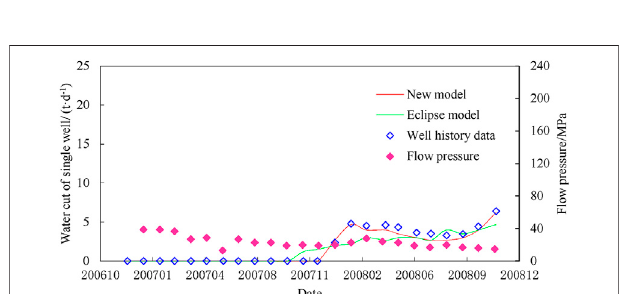
FIGURE 11 | The water cut comparison results of the well W587-X3.